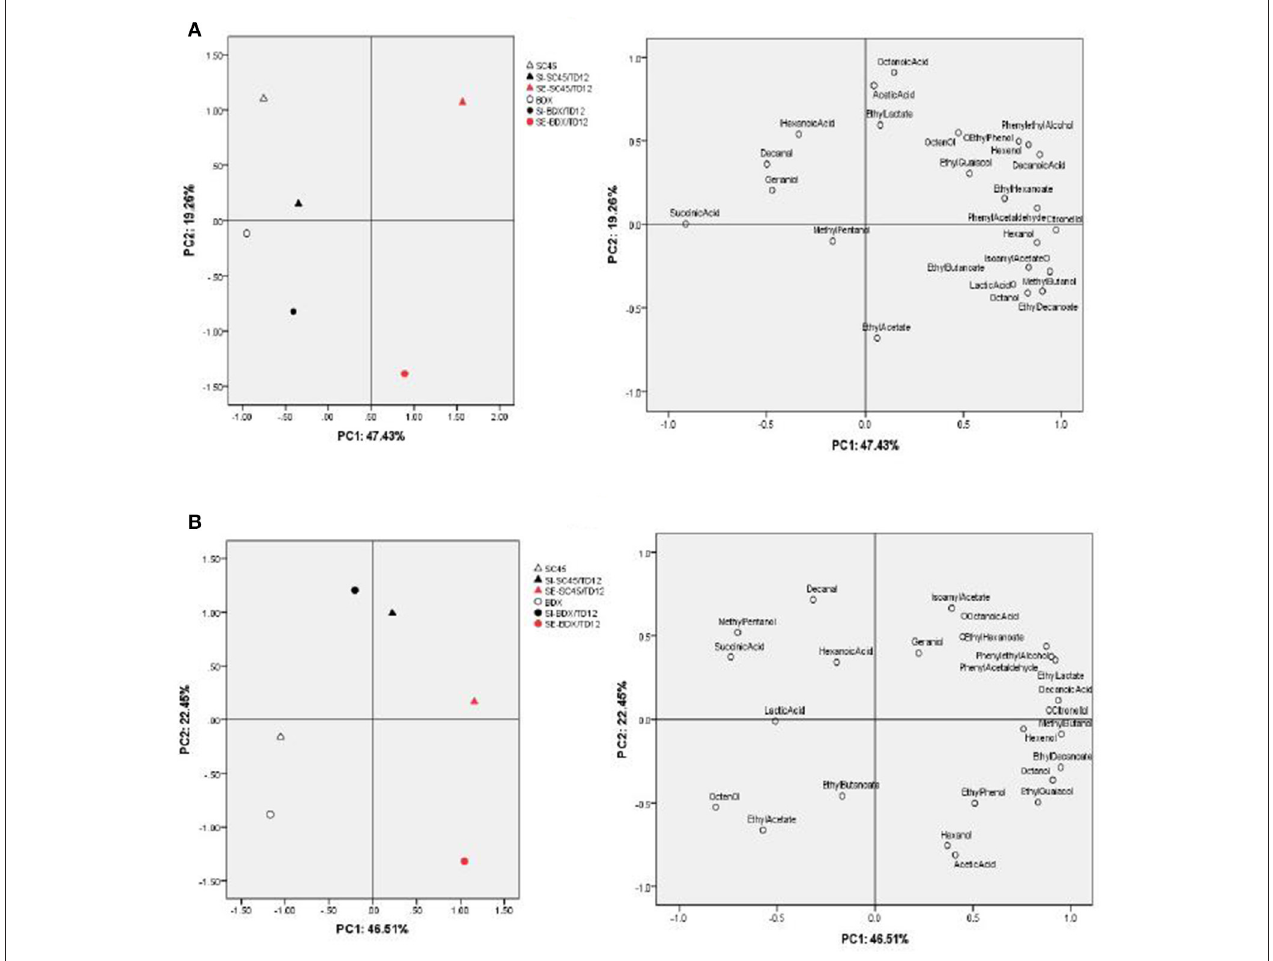
FIGURE 2 | Principal component analysis (PCA) biplots of wines resulting from 22 aromatic compounds (OAV above 0.1) and 3 organic acid (succinic acid, lactic acid, acetic acid) by different fermentation methods after alcoholic fermentation (A) and malolactic fermentation (B) , respectively.